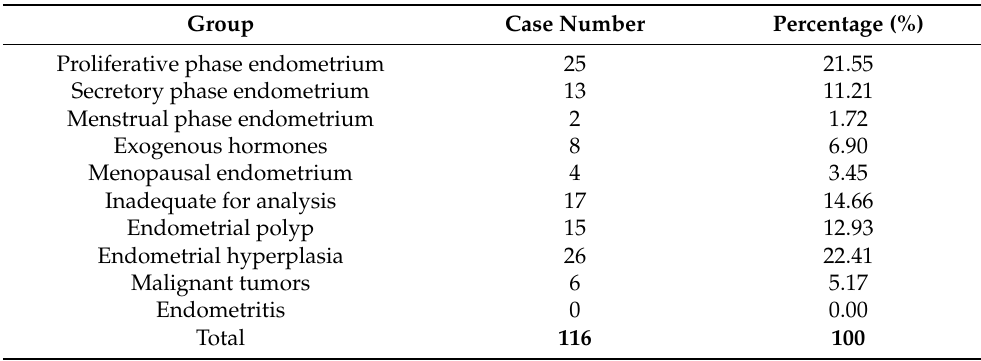
Table 7. Histopathological findings of samples extracted by hysteroscopy with endometrial biopsy procedure.